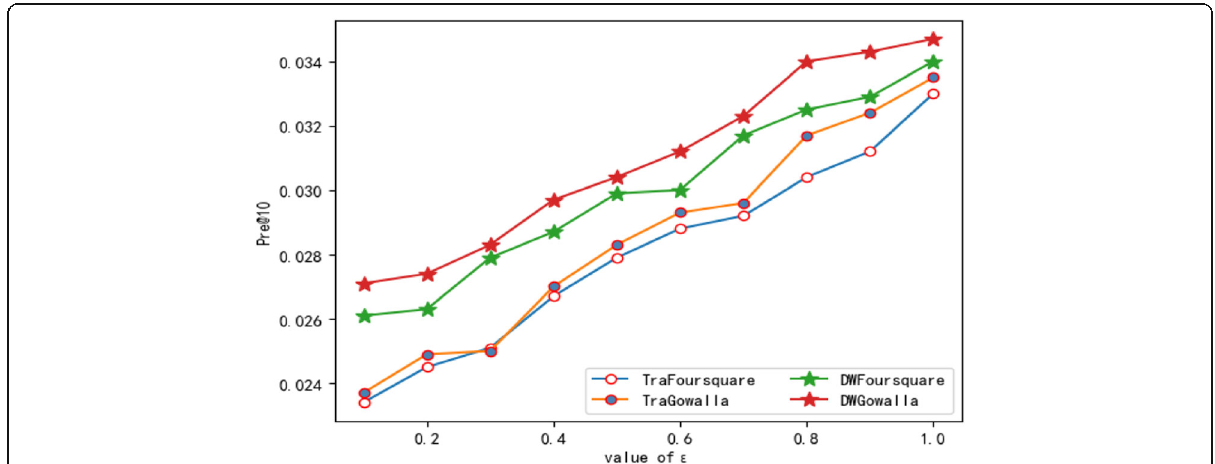
Fig. 5 Recommendation accuracy with perturbed